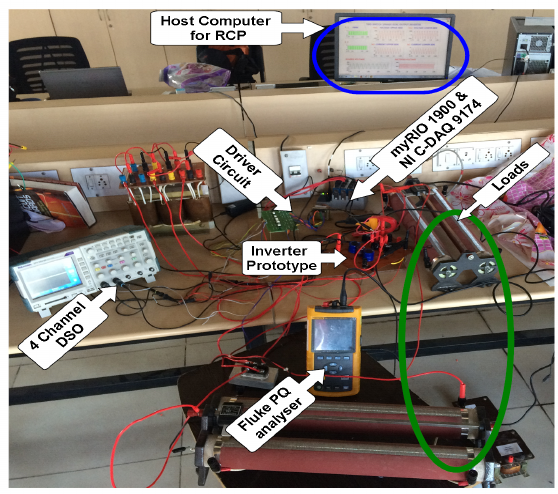
Figure 5. Experimental